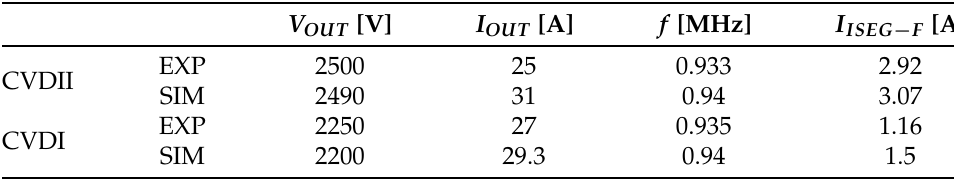
Table 1. Comparison between measurements performed in SPIDER (EXP) and circuital simulation (SIM) in the original (CVD II) and modified (CVD I) configurations. The figure of merit for the RF stray currents is the current measured at the ISEG output filter branch ( I ISEG − F ). All the voltage and current values are